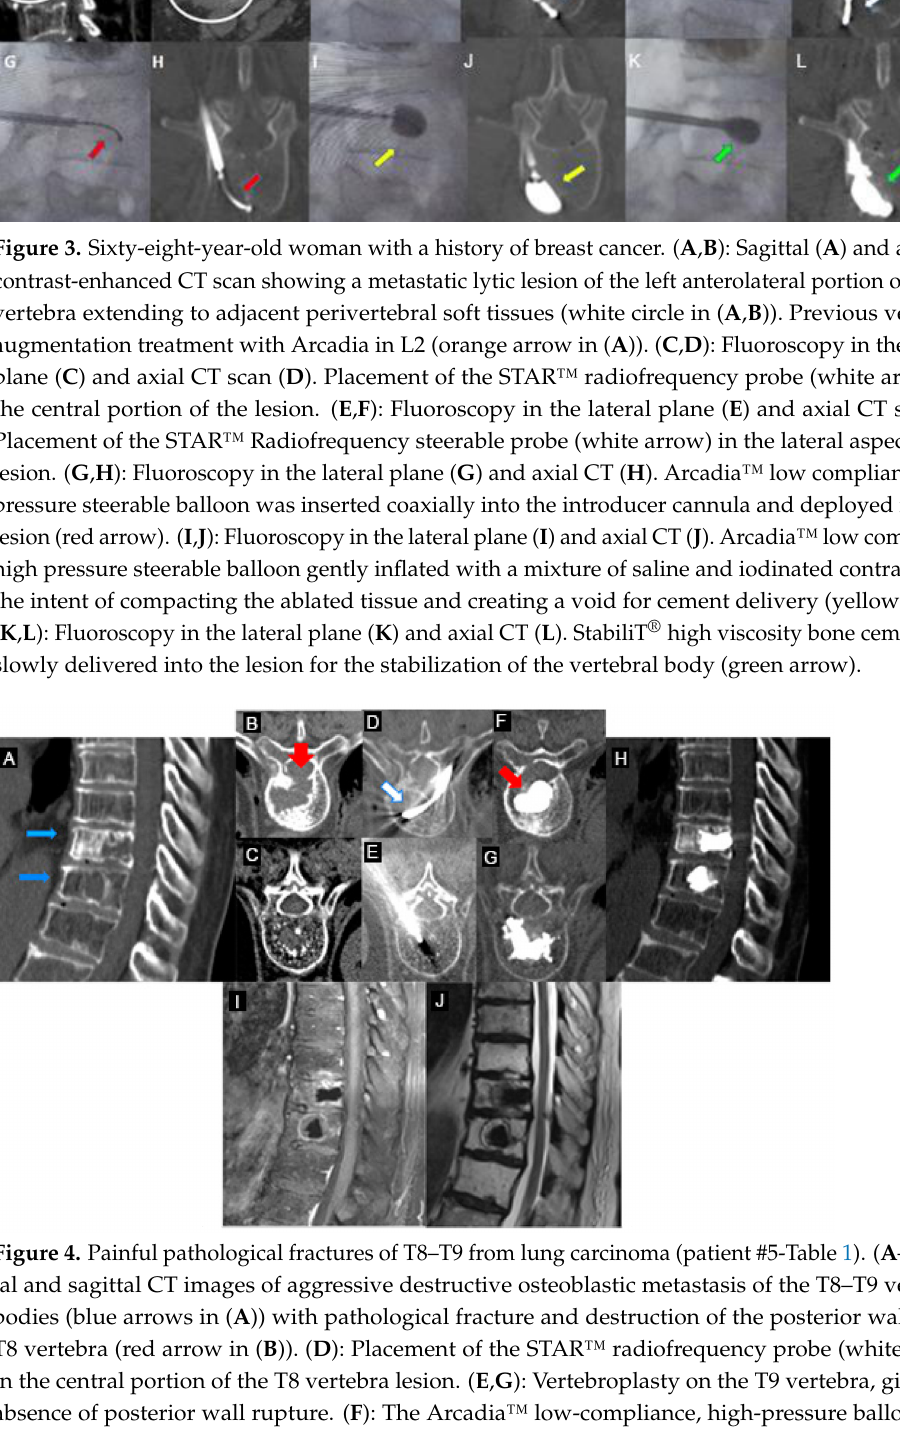
Figure 4. Painful pathological fractures of T8–T9 from lung carcinoma (patient #5-Table 1). ( A – C ): Axial and sagittal CT images of aggressive destructive osteoblastic metastasis of the T8–T9 vertebral bodies with pathological fracture and destruction of the posterior wall of the T8 vertebra (red arrow in ( B )). ( D ): Placement of the STAR™ radiofrequency probe (white arrow) in the central portion of the T8 vertebra lesion. ( F ): The Arcadia™ low-compliance, high-pressure balloon was coaxially inserted into the introducer cannula and deployed into the lesion (red arrow). Note the inflation of the low-compliance Arcadia balloon after RFA and the predictable cement distribution. ( E – G ): Vertebroplasty on the T9 vertebra, given the absence of posterior wall rupture. ( H – J ): Post-vertebroplasty CT ( H ) and MRI ( I , J ) sagittal images post procedural control T8 and T9 without complications.